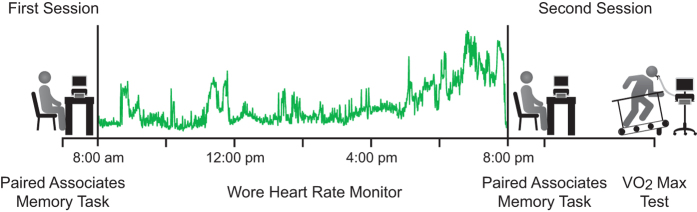
Schematic illustration of the progression of procedures utilized by the current investigation.Participants first completed the training and initial assessment of the paired associates memory task. Participants then wore a heart rate monitor that continuously recorded heart rate in 20 second epochs throughout the day. Approximately 12 hours later, participants were tested on the paired associates memory task and then completed a brief test of their aerobic fitness.